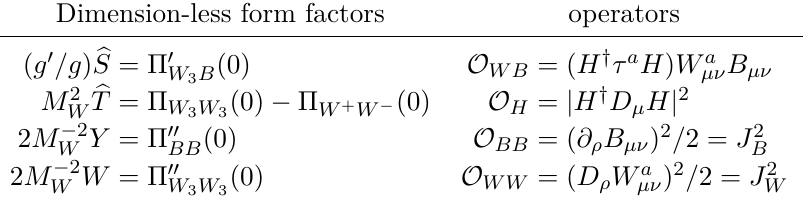
Table 1. The first column defines the dimension-less form factors. The second column defines the SU(2) -invariant universal dimension-6 operators, which contribute to the form-factors on the same L row. We use canonically normalized fields and inverse propagators Π( k 2 ) = k 2 − M 2 + · · · and denote as g, g 0 the SU(2) U(1) SM gauge L ⊗ Y